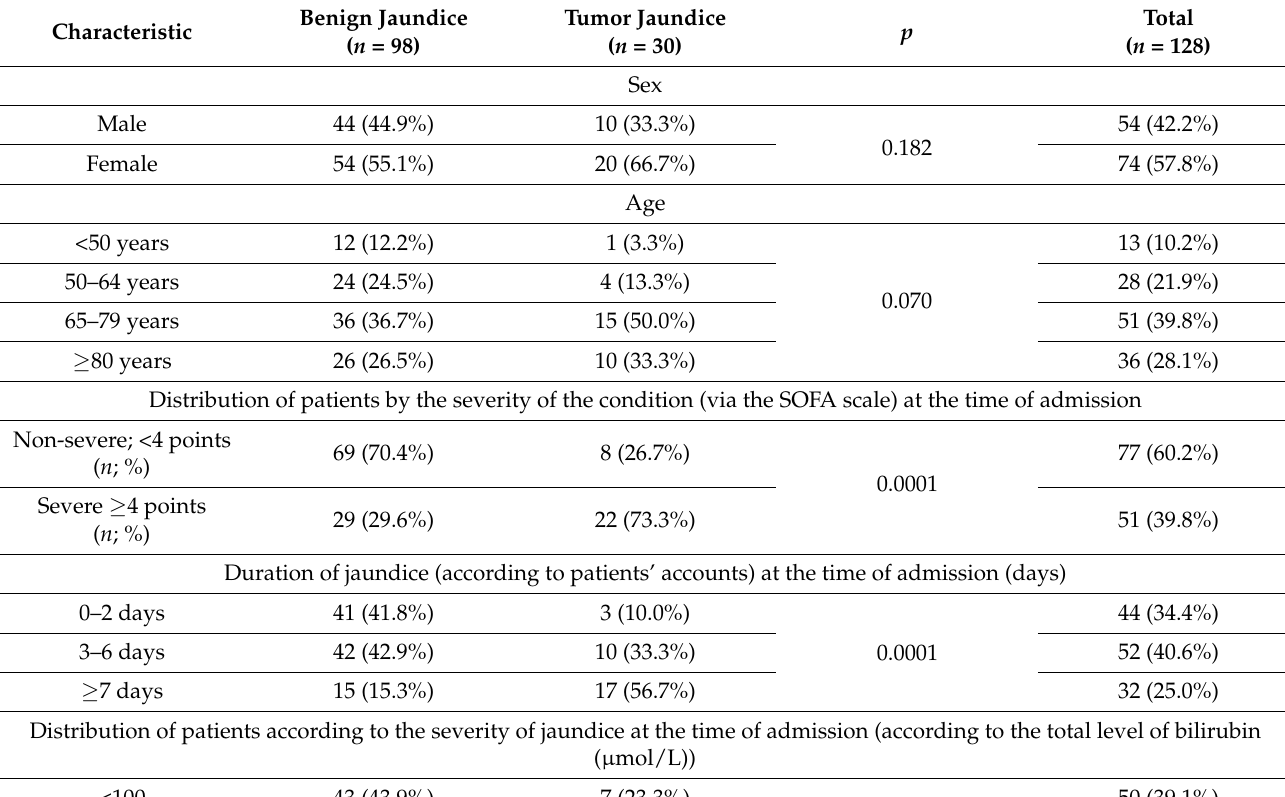
Table 1. Distribution of patients by sex, age, duration and severity of tumorous and non- tumorous